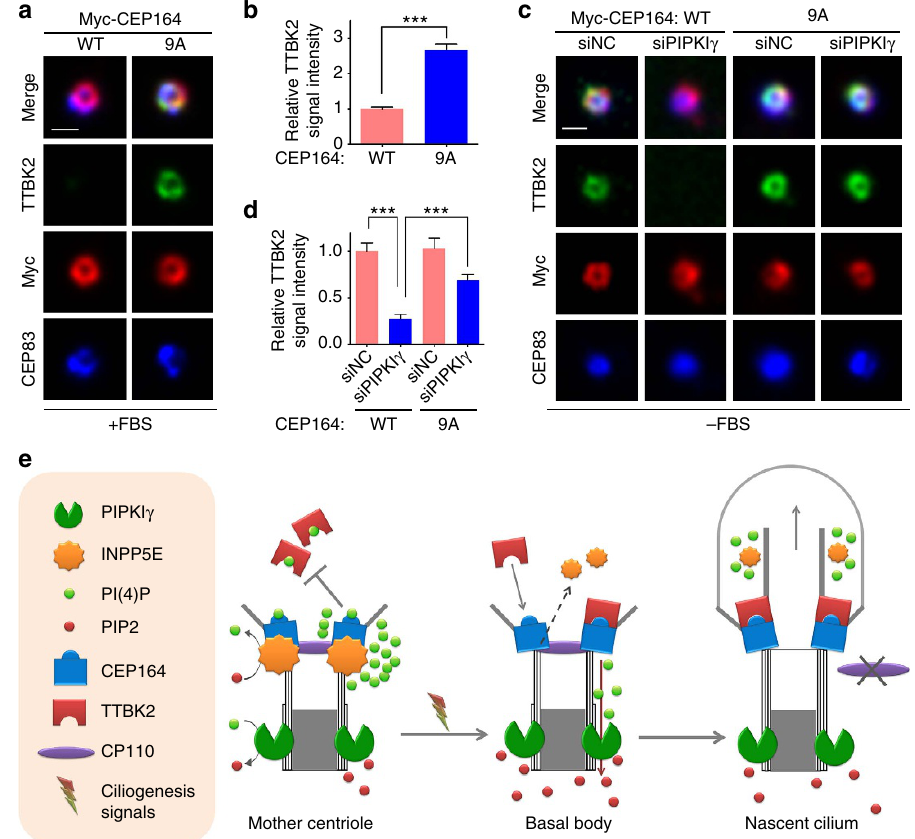
Figure 7 | Centrosomal PtdIns(4)P homoeostasis at the M-centriole/basal body. ( a , b ) RCTE cells stably expressing GFP-TTBK2 were transfected with wild type (WT) or mutated Myc-tagged CEP164 (9A) for 24h and subjected to IF microscopy after stained with indicated antibodies. ( b ) The fluorescence intensity of centrosomal TTBK2 in 4 20 cells of each group quantified from three independent experiments and plotted. ( c , d ) RCTE cells stably expressing GFP-TTBK2 were transfected with negative control (siNC) or PIPKI g siRNA (siPIPKI g ) for 24h followed by transfection with wild type (WT) or mutant Myc-CEP164 (9A) for another 24h. After being serum starved for additional 24h to induce the translocation of TTBK2 to the M-centriole/basal body, these cells were stained with indicated antibodies for IF microscopy. ( d ) The fluorescence intensity of centrosomal TTBK2 was quantified in each group ( n 4 20 cells). Results from three independent experiments were analysed and plotted using Excel. Error bars represent s.e.m. *** P o 0.001. Scale bars, 0.5 m m. ( e ) Schematic model summarizing the results of current study. In proliferating cells, INPP5E localizes at the distal end of the M-centriole and plays a key role in repelling TTBK2 by maintaining a local PtdIn(4)P (PI(4)P) pool that inhibits the interaction of TTBK2 with CEP164. In quiescent cells when INPP5E leaves the centrosome, the centrosomal PIPKI g promotes the TTBK2 recruitment and the initiation of ciliary axoneme elongation by consuming the PI(4)P at the centrosome. PIP2, PtdIns(4,5)P 2